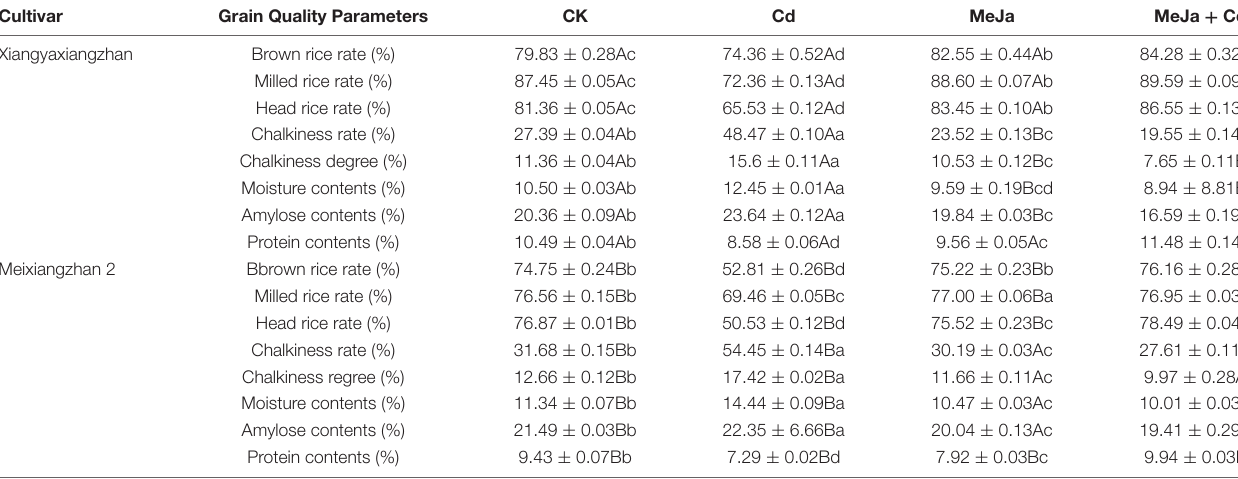
TABLE 3 | The effects of exogenous MeJa application on grain quality attributes in two fragrant rice cultivars under Cd stress. Cultivar